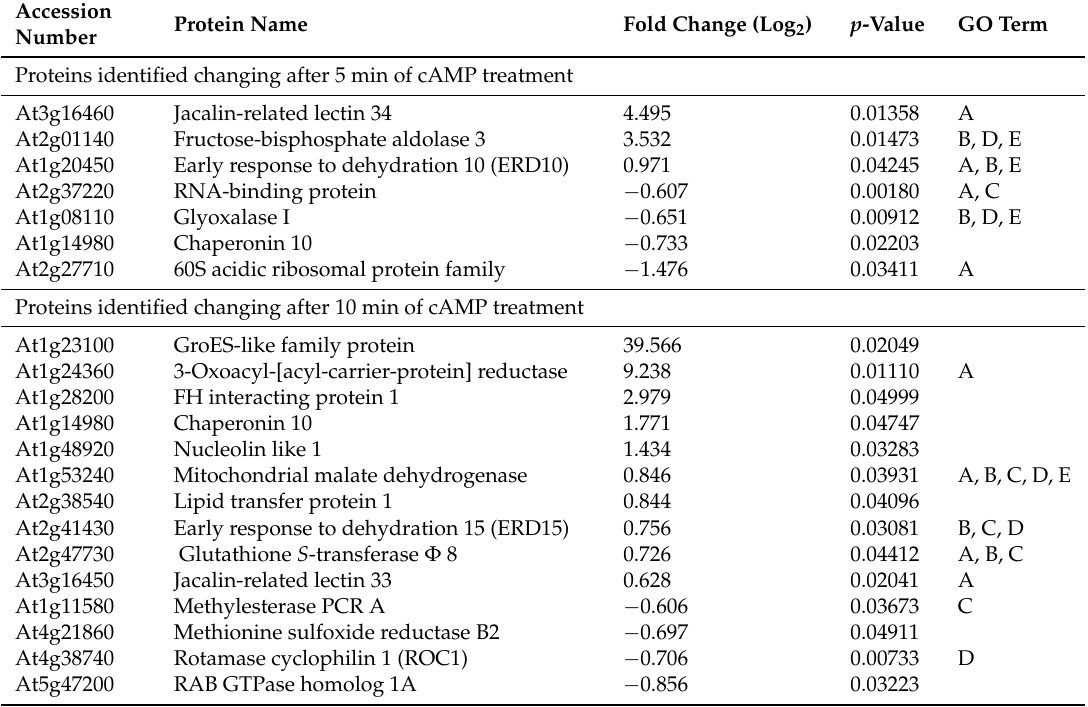
3’,5’-Cyclic adenosine monophosphate (cAMP)-responsive proteins after 5 and 10 min